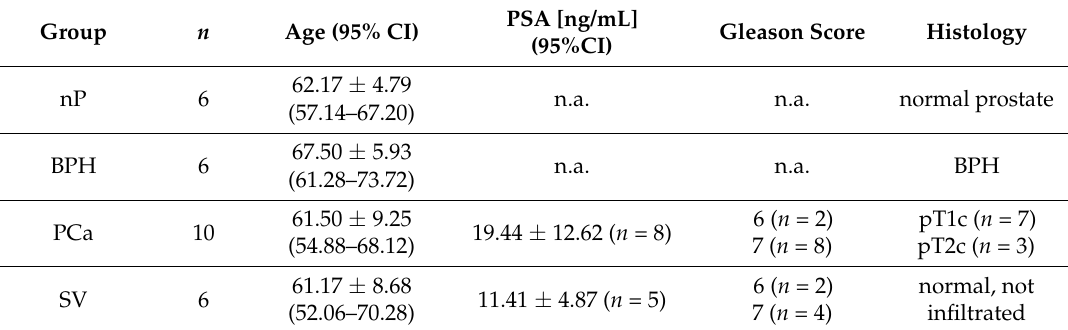
Table 4. Characteristics of patients used for immunofluorescence